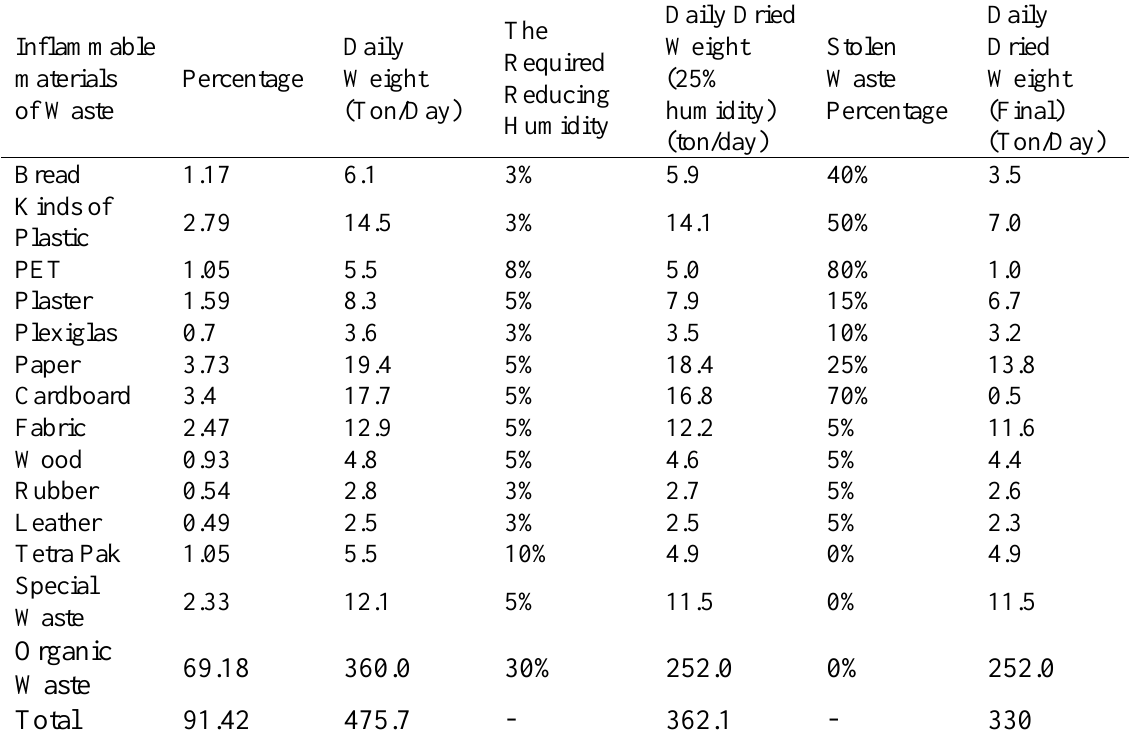
Table 5 . Calculating the dried waste usable for producing SRF